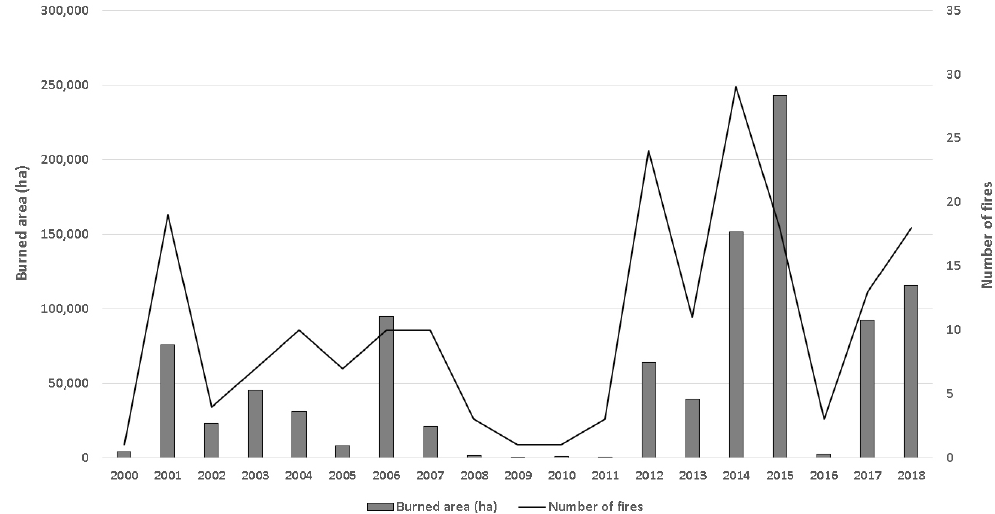
Figure 2. Burned area and number of fire events greater than 100 ha for the period of 2000–2018. Data source: LANDFIRE disturbances [16] and Monitoring Trends in Burn Severity [42] .